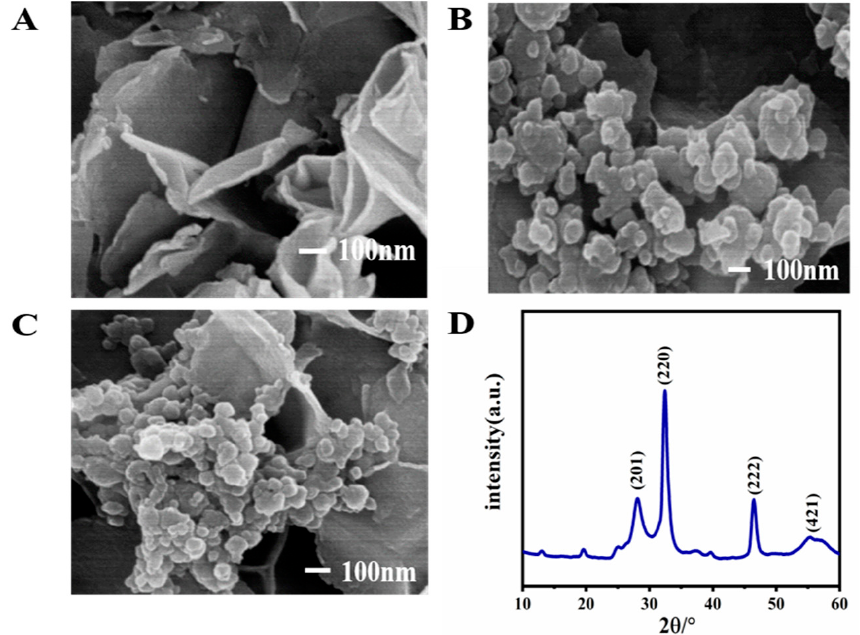
Figure 1. SEM images of ( A ) β -Bi 2 O 3 ; ( B ) MIP/ β -Bi 2 O 3 /ITO before elution and ( C ) after elution. ( D ) XRD pattern of β -Bi 2 O 3 .